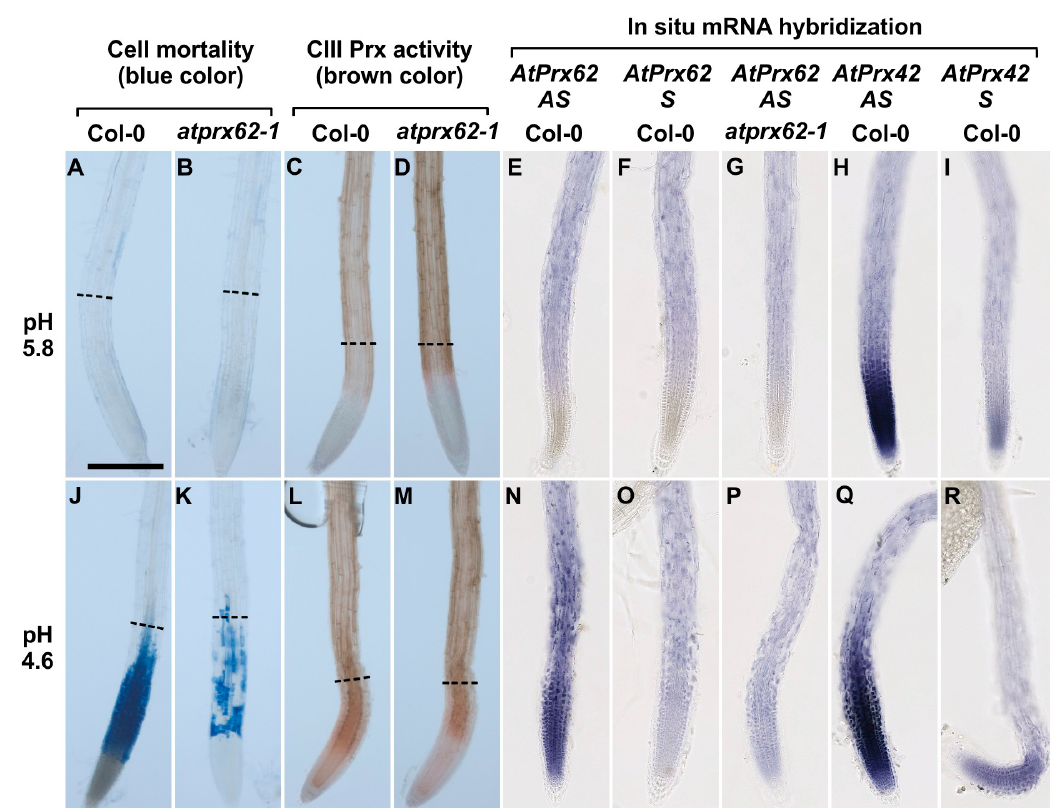
Figure 4. Low pH dependent spatio-temporal correlation between cell mortality, CIII Prx activity, and AtPrx62 expression in Arabidopsis thaliana roots. Col-0 ( A , C , E , F , H , I , J , L , N , O , Q , R ) and atprx62-1 (KO mutant) ( B , D , G , K , M , P ) roots treated at pH 5.8 ( A – I ) or pH 4.6 ( J – R ) for 2 h were stained with Evans blue for cell mortality (A,B,J,K), stained with guaiacol / H 2 O 2 for CIII Prx activity ( C , D , L , M ) or hybridized with AtPrx62 digoxygenin-labeled antisense (AS) or sense (S) probes used as negative controls ( E – G , N – P ). Positive control with the AtPrx42 probes was performed as labeled ( H , I , Q , R ). The dashed lines ( A – D ; J – M ) show the upper limit of the regions of interest (ROIs) used for quantification on biological repeats (see Figure 5). Scale bar: 200 µ m. For cell mortality and CIII Prx activity, three independent experiments were performed with similar results and representative images are shown ( A – D ; J – M ). For in situ hybridization, two independent experiments with 25 biological replicates (roots) were performed with similar results and representative images are shown ( E – I ; N – R ). Note that the spatiotemporal correlation between the low pH-induced cell mortality ( J ), CIII-Prx activity ( L ), and AtPrx62 expression ( N ) occurring around the transition zone in Col-0 was strongly reduced or lost in atprx62-1 ( K , M , P ). Note also that the specificity of the AtPrx62 expression pattern ( N ) was attested by comparison with the similar background signals observed with the AtPrx62 sense negative control probe in Col-0 ( O ) and AtPrx62 antisense probe in atprx62-1 ( P ). Finally, note that the specificity of the induction of AtPrx62 expression upon low pH treatment ( E , N ) is reinforced by the constitutive expression of AtPrx42 observed with the AtPrx42 antisense probe ( H , Q